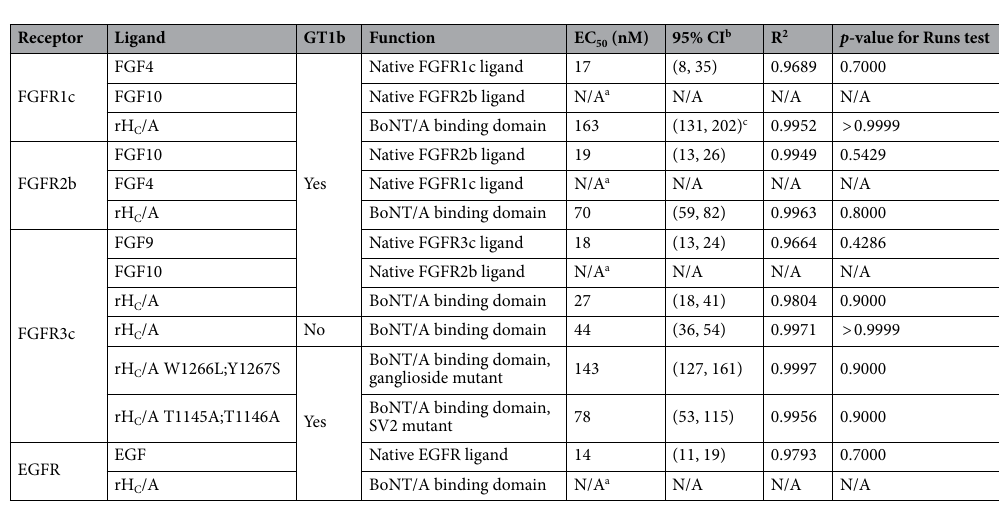
Table 1. FCS & TIRF receptor dimerization assay—results summary. a No binding observed at highest dose of ligand tested. b Based on 3PL with bottom > 1, top = 2. c Based on 2PL with bottom = 1, top = 2.